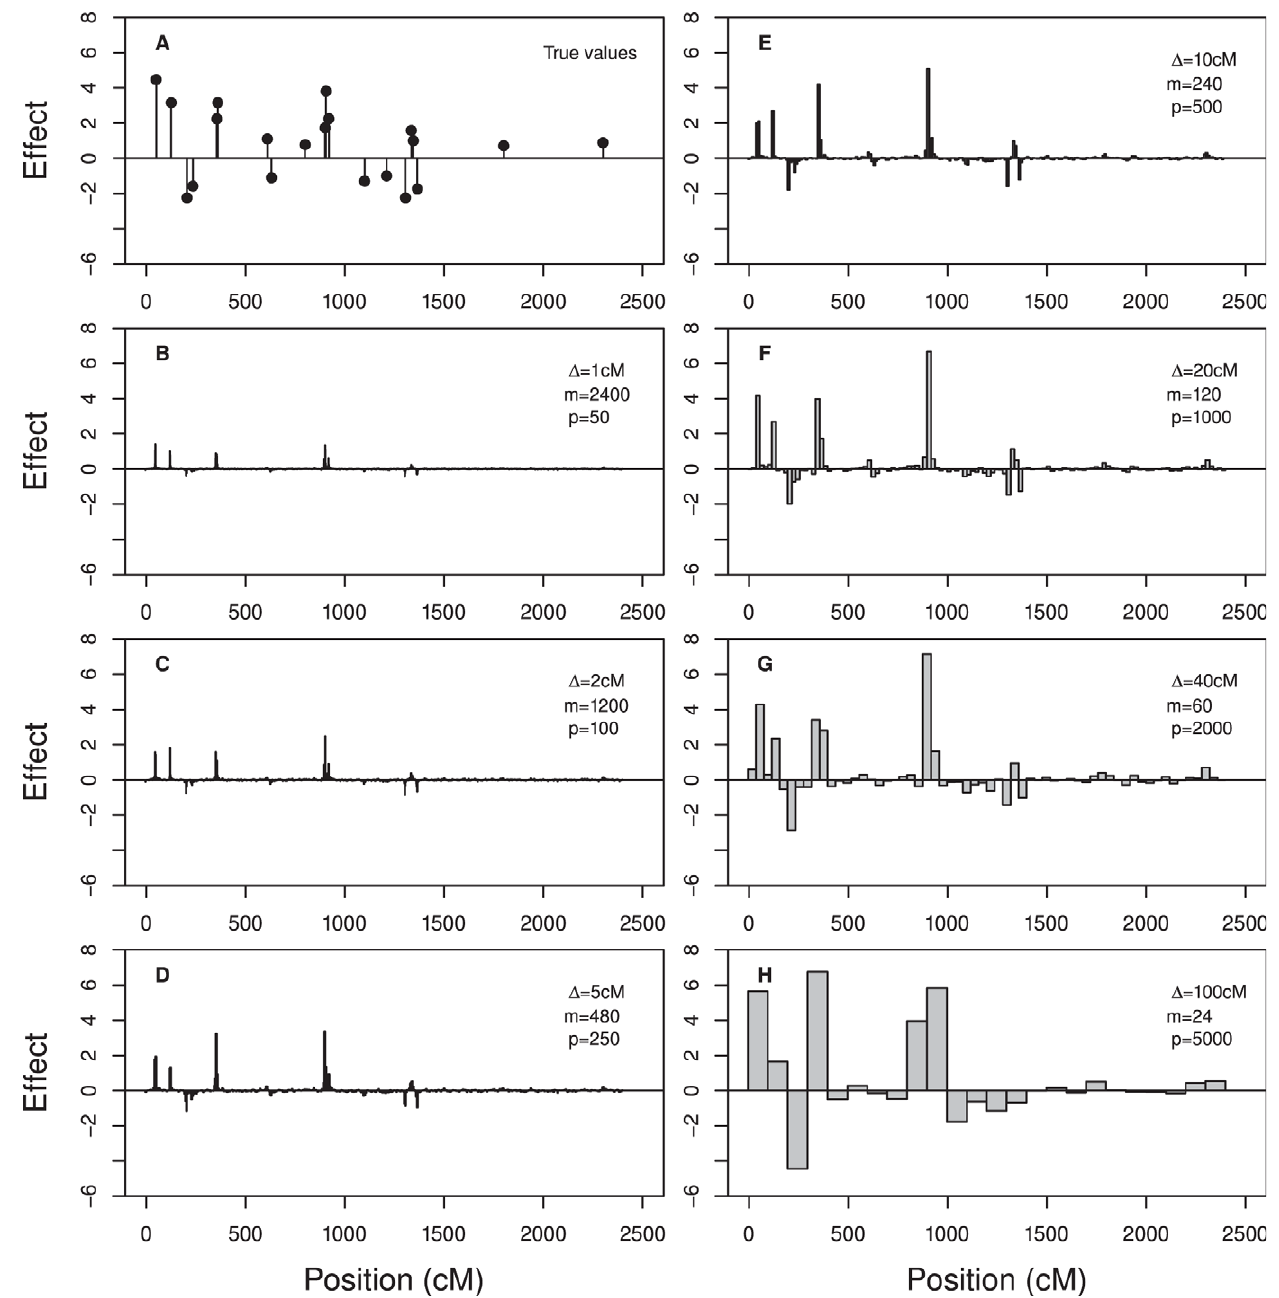
Figure 1. True QTL effects and estimated bin effects for design I. The bin effect estimates were obtained from 100 replicated simulations. The total number of markers was 120,001. The sample size was n ~ 500 . The pure environmental error variance was s 2 ~ 20 . The 20 simulated QTL collectively explained 0.581 of phenotypic variance. The three symbols represent the size of bin ( D k ), the number of markers (model dimension) within a bin (m) and the number of markers per bin ( p k ). Since the bin size and number of markers per bin are constant across bins, the subscript k has been removed from the figure